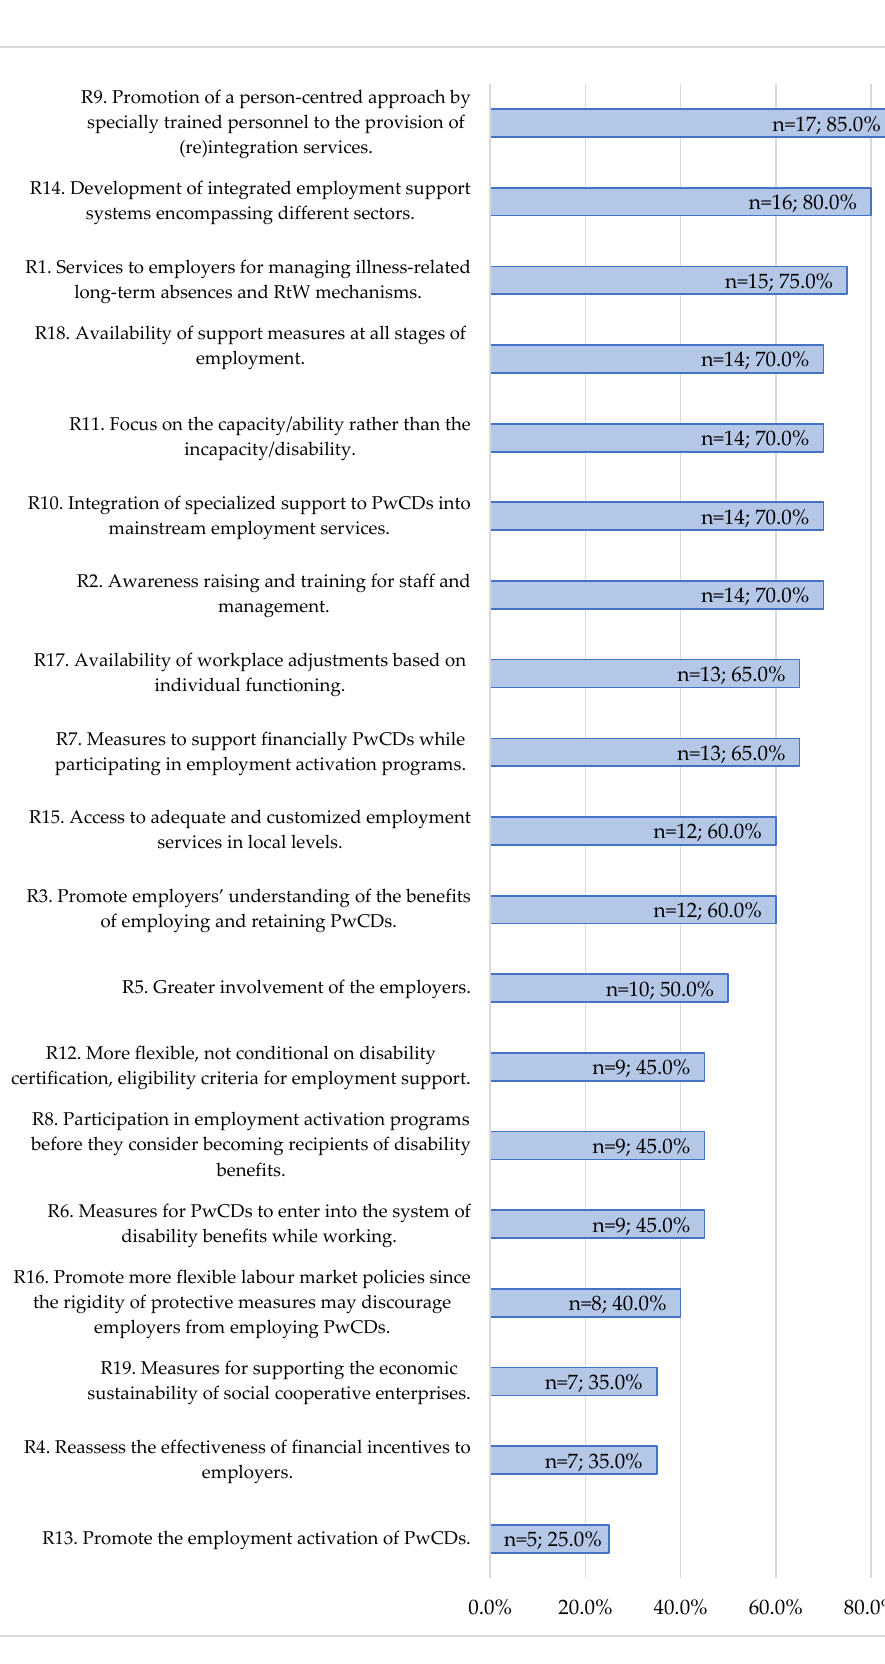
Figure 4. Recommendations’ ranking based on “very important” response rates.